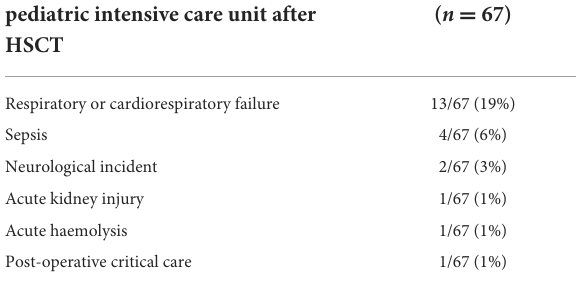
TABLE 3 Indications for PICU